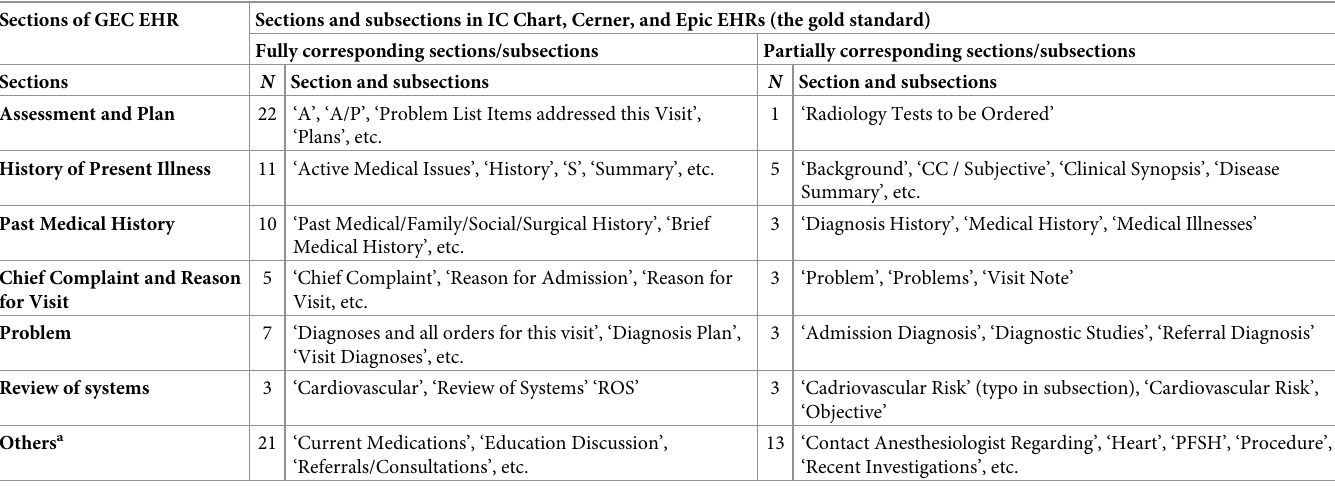
Table 1. Corresponding sections and subsections among test corpora. Sections of GEC EHR